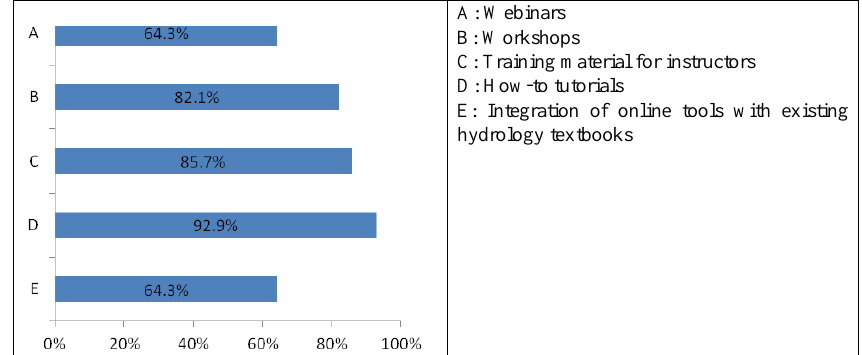
Fig. 2. Percentages of workshop participant survey respondents ( N =37) rating specific learning community cyberinfrastructure training and Figure 2: Percentages of workshop participant survey respondents (N = 37) rating specific equipping resources as important for their personal learning community cyberinfrastructure training and equipping resources as important for their personal applications.